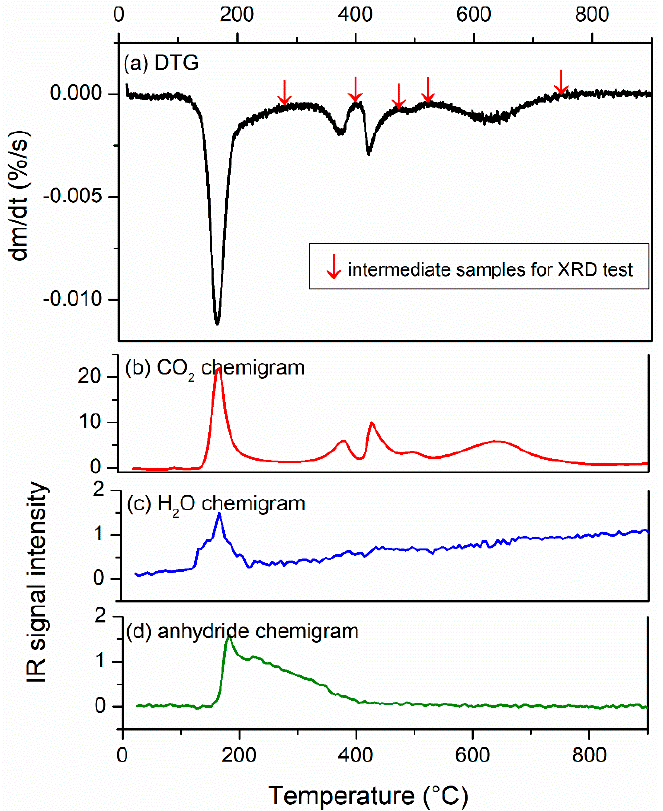
Figure 1. TGA − FTIR results of NA − C under N 2 at the heating rate of 5 °C/min: ( a ) DTG curve, ( b ) CO 2 evolution profile, ( c ) H 2 O evolution profile, and ( d ) anhydride evolution profile.